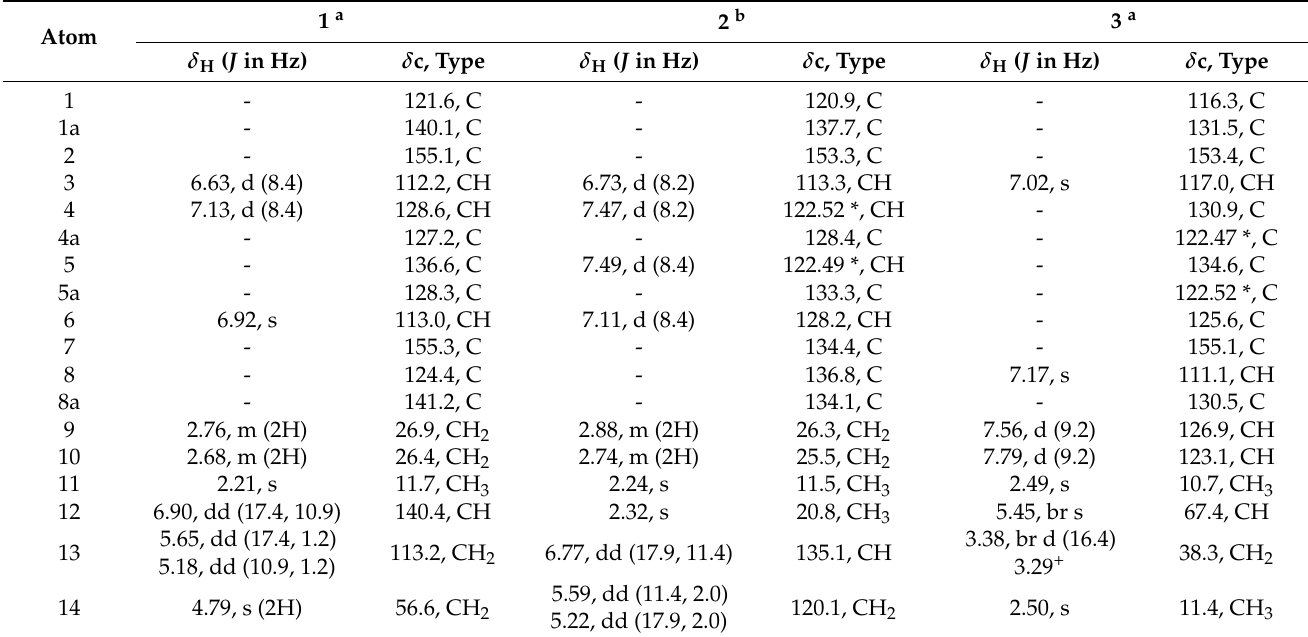
Table 1. 1 H (500 MHz) and 13 C (125 MHz) NMR data of compounds 1 – 3